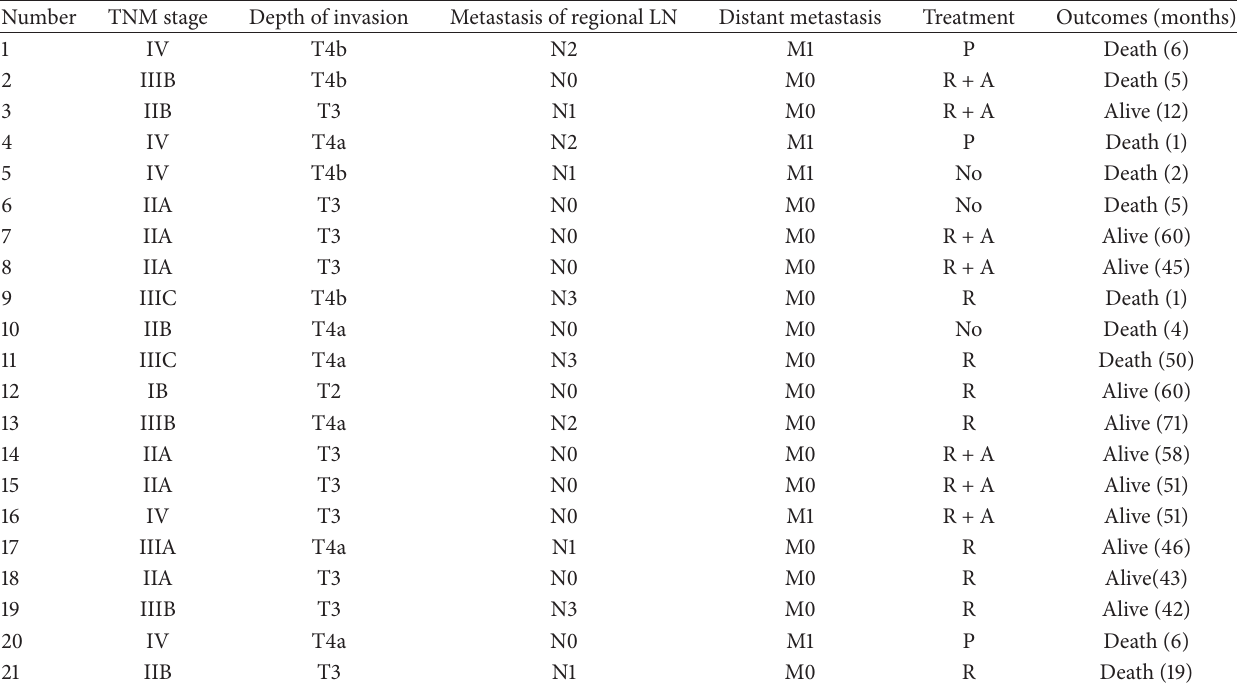
Table 2: Clinicopathological characteristics and survival outcomes of 21 patients with